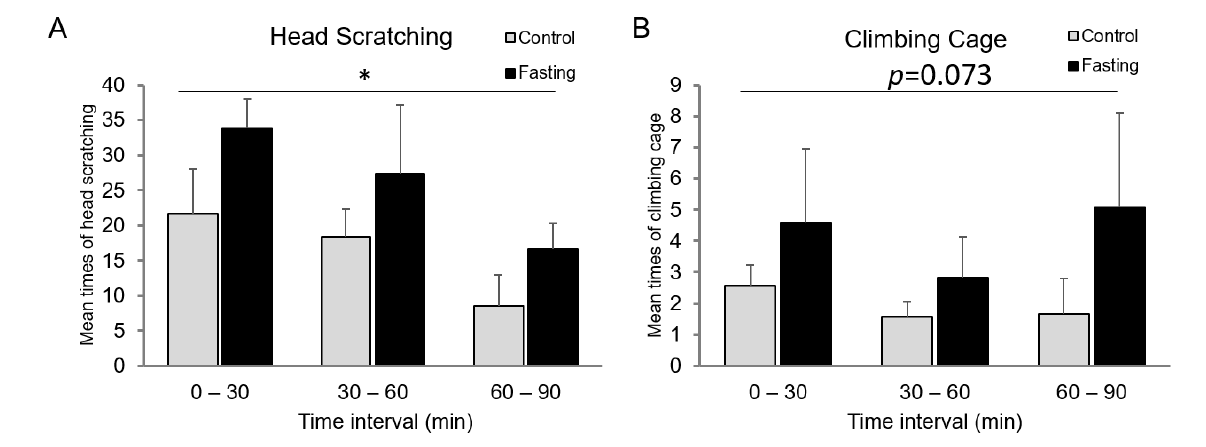
Figure 1. Headache caused by NTG is more serious in fasting group. ( A ) Mean times of head scratching were increased in the fasting group compared to the control group at different time intervals. ( B ) Mean cage-climbing times of mice were increased in the fasting group compared to the control group at different time intervals. NTG, nitroglycerin, 10 mg/kg, subcutaneous injection. The fasting group mice were starved for 16 h. n = 12. * p < 0.05.